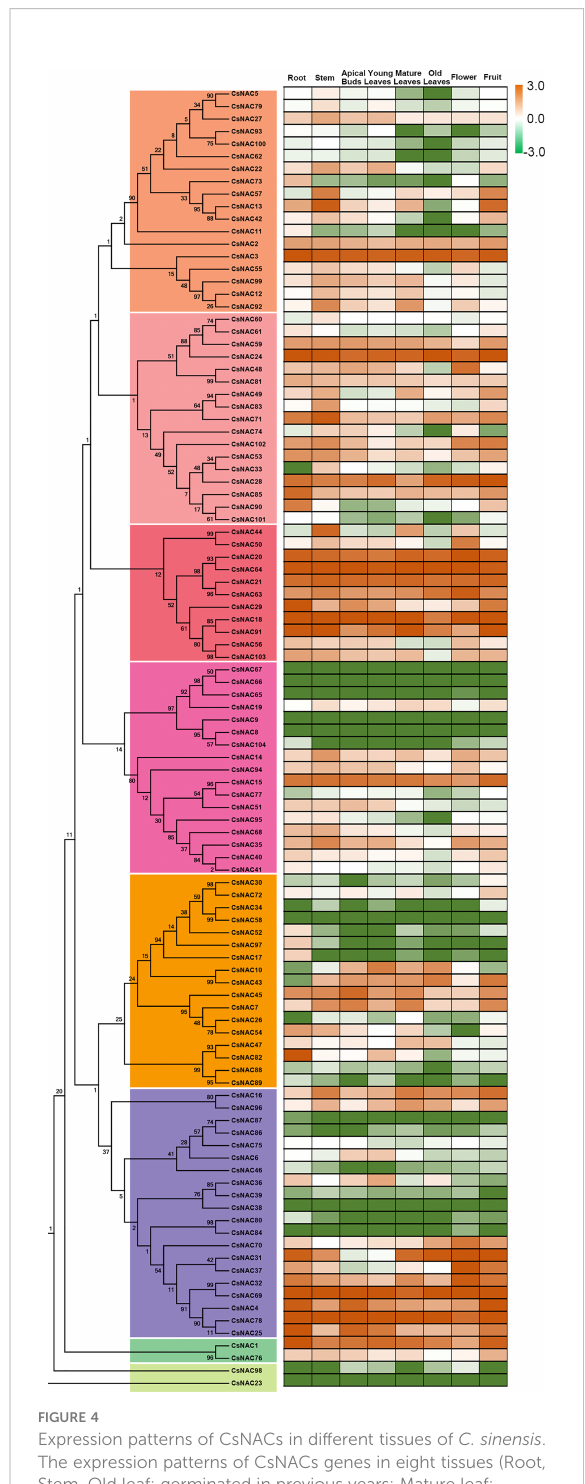
FIGURE 4 Expression patterns of CsNACs in different tissues of C. sinensis